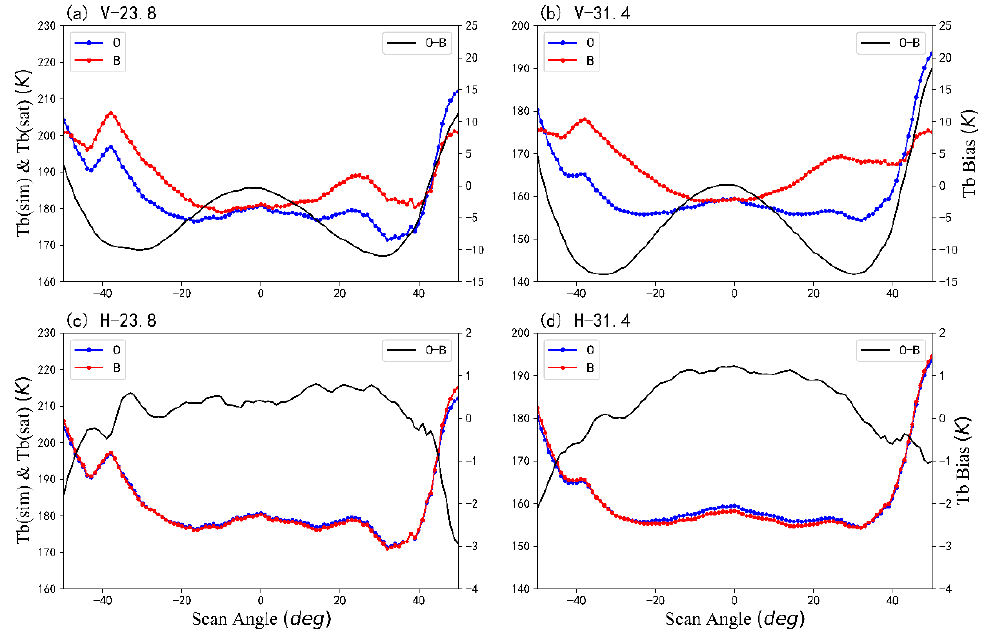
Figure 3. Mean bias (O − B, unit: K) of observed (O, unit: K) and simulated (B, unit: K) brightness temperatures under clear atmospheres over oceans at ( a ) 23.8 GHz with qv -pol; ( b ) 31.4 GHz with qv -pol; ( c ) 23.8 GHz with qh -pol; ( d ) 31.4 GHz with qh -pol.